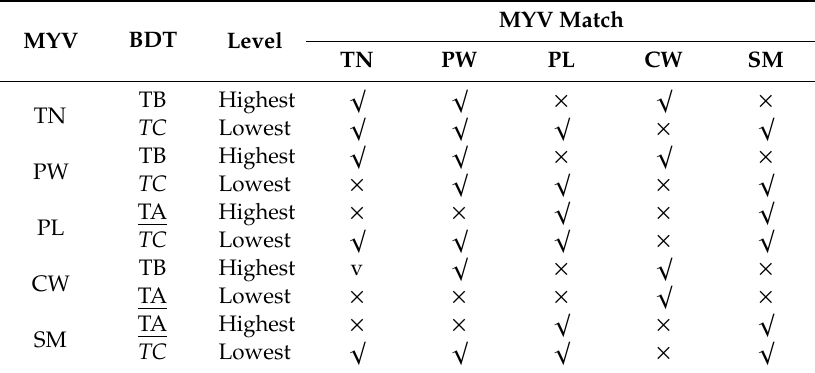
Table 2. A table depicting the match of the biochar depth treatments (BDT) with the highest and lowest values of the measured yield variables (MYV) of NERICA-4 rice plant under tropical rainfed